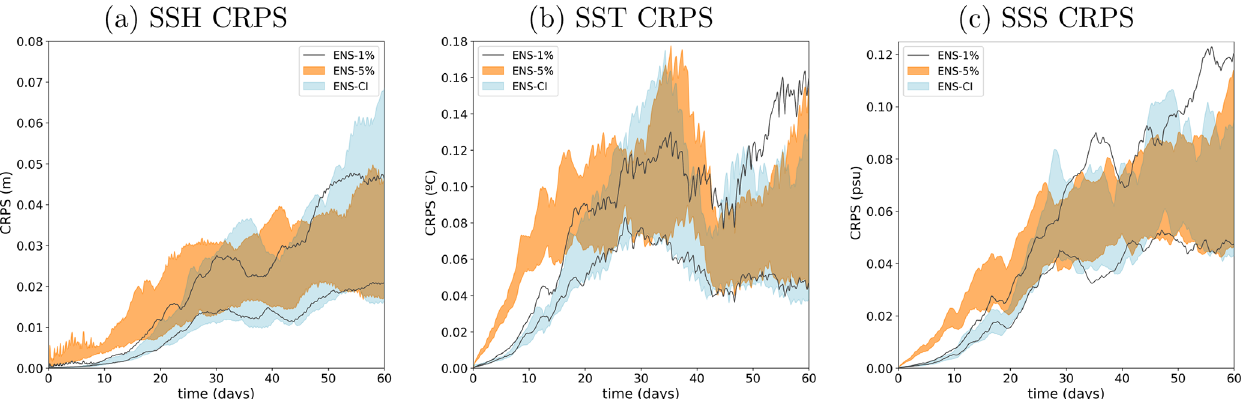
Figure 10. CRPS score as a function of time for (a) SSH (meters), (b) SST (degree Celsius) and (c) SSS (psu), compared for the three simulations: ENS-CI (no model uncertainty, blue shading), ENS-5% (larger model uncertainty, orange shading) and ENS-1% (small model uncertainty, gray lines). Only the minimum-to-maximum envelop of all the 20 individual CRPS scores is represented for each experiment (the 20 individual scores are omitted).